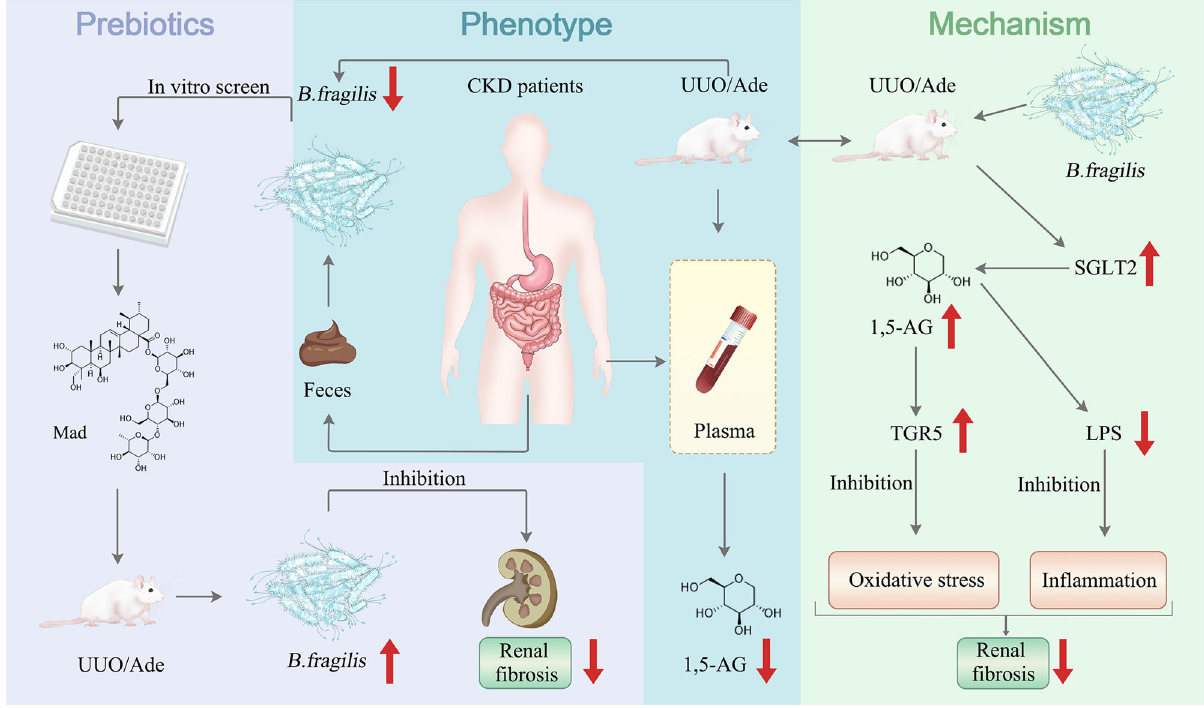
Fig. 8 | Proposed mechanism for the inhibition of renal fi brosis by B. fragilis . The relative abundance of B. fragilis is decreased in the feces of CKD patients and UUO mice. Oral administration of live B. fragilis attenuates renal fi brosis in UUO and adenine mice models. Increased LPS levels are decreased after B. fragilis